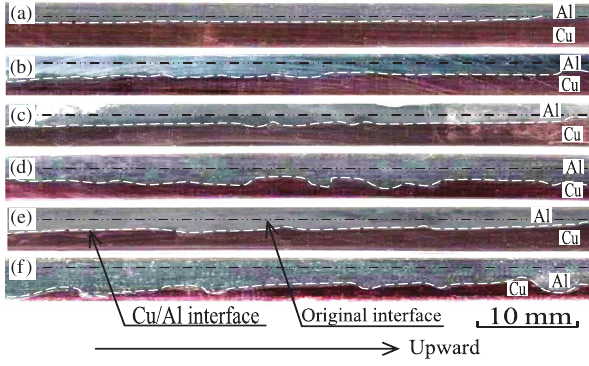
Figure 4: Vertical section photographs of CCA composite castings a, c, e, l Cu / l Al = 4/30; b, d, f, l Cu / l Al = 4/50 a, b: Spray cooling; c,